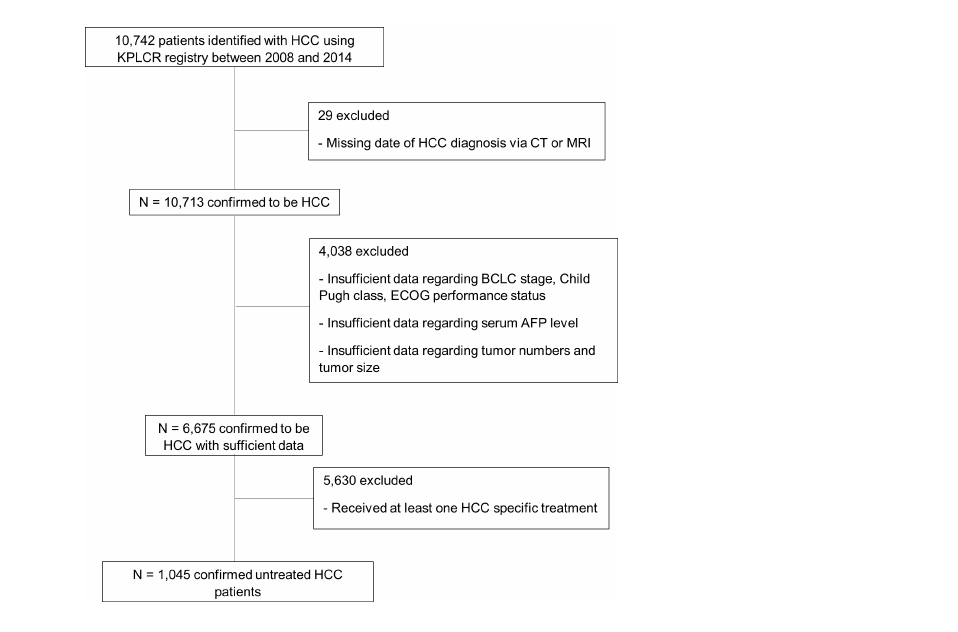
FIGURE 1 Flowchart showing the enrolment of study